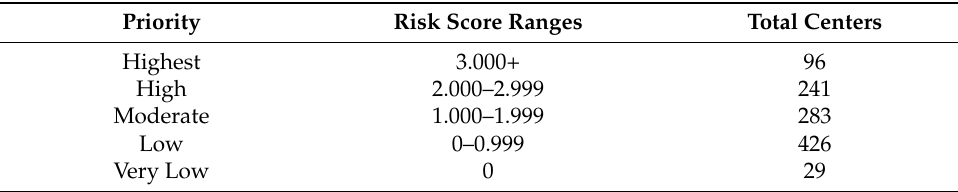
Table 3. Community lead risk category for childcare